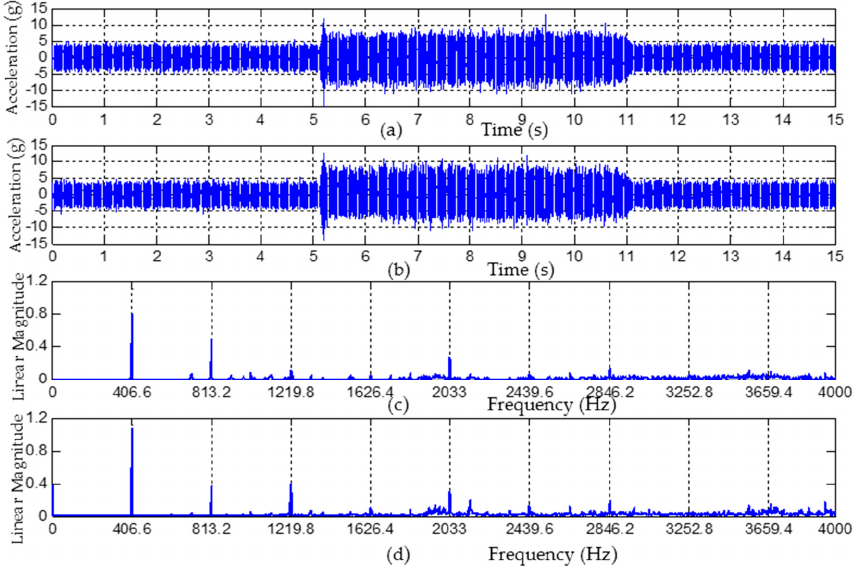
Figure 9. The results of steady cutting process by using PZT and MEMS accelerometers. ( a ) Time domain response of PZT type; ( b ) Time domain response of MEMS type; ( c ) Frequency response of PZT type; ( d ) Frequency response of MEMS